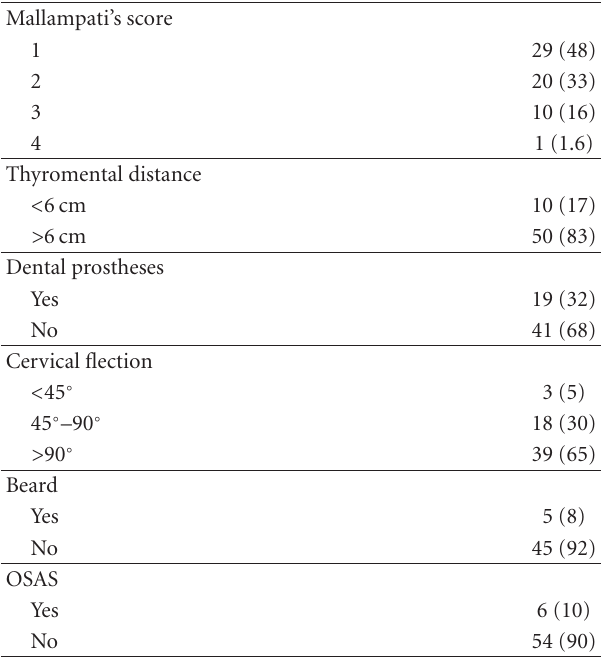
Table 2: Airway evaluation. Data are shown as absolute number of patients (percentage). OSAS: obstructive sleep apnea syndrome.